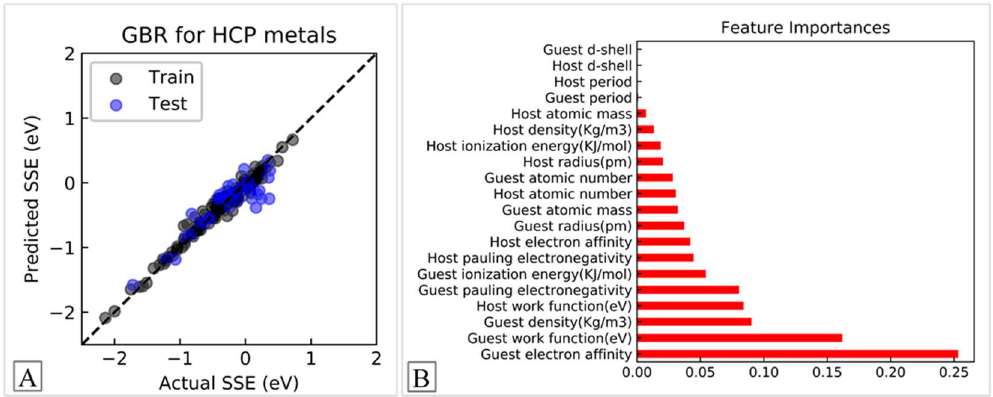
Figure 7. ( A ) Model predictions and ( B ) Feature importance scores for HCP(001) surfaces obtained from the GBR model. SSE = surface segregation energy.